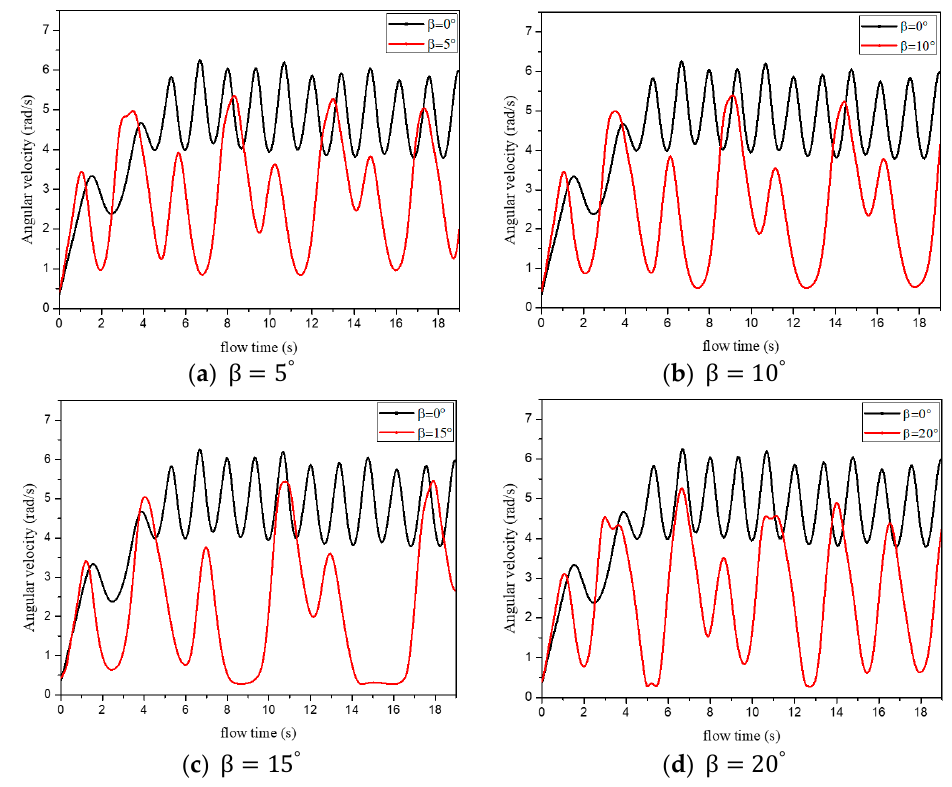
Figure 9. Time history curve of the turbine rotation angular velocity at different inclination angles.